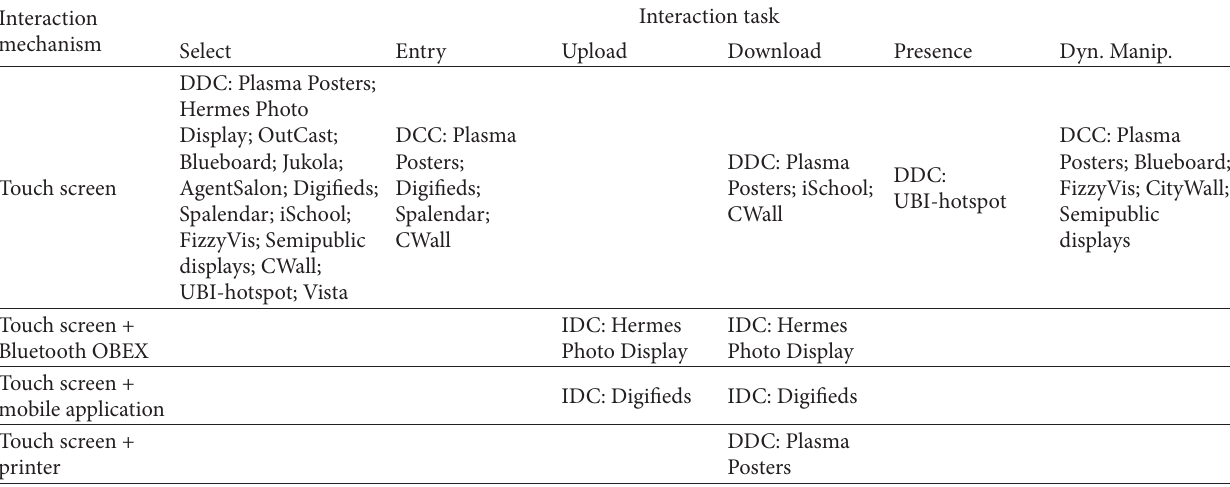
Table 2: Mapping between interaction tasks and touch-screen based interaction